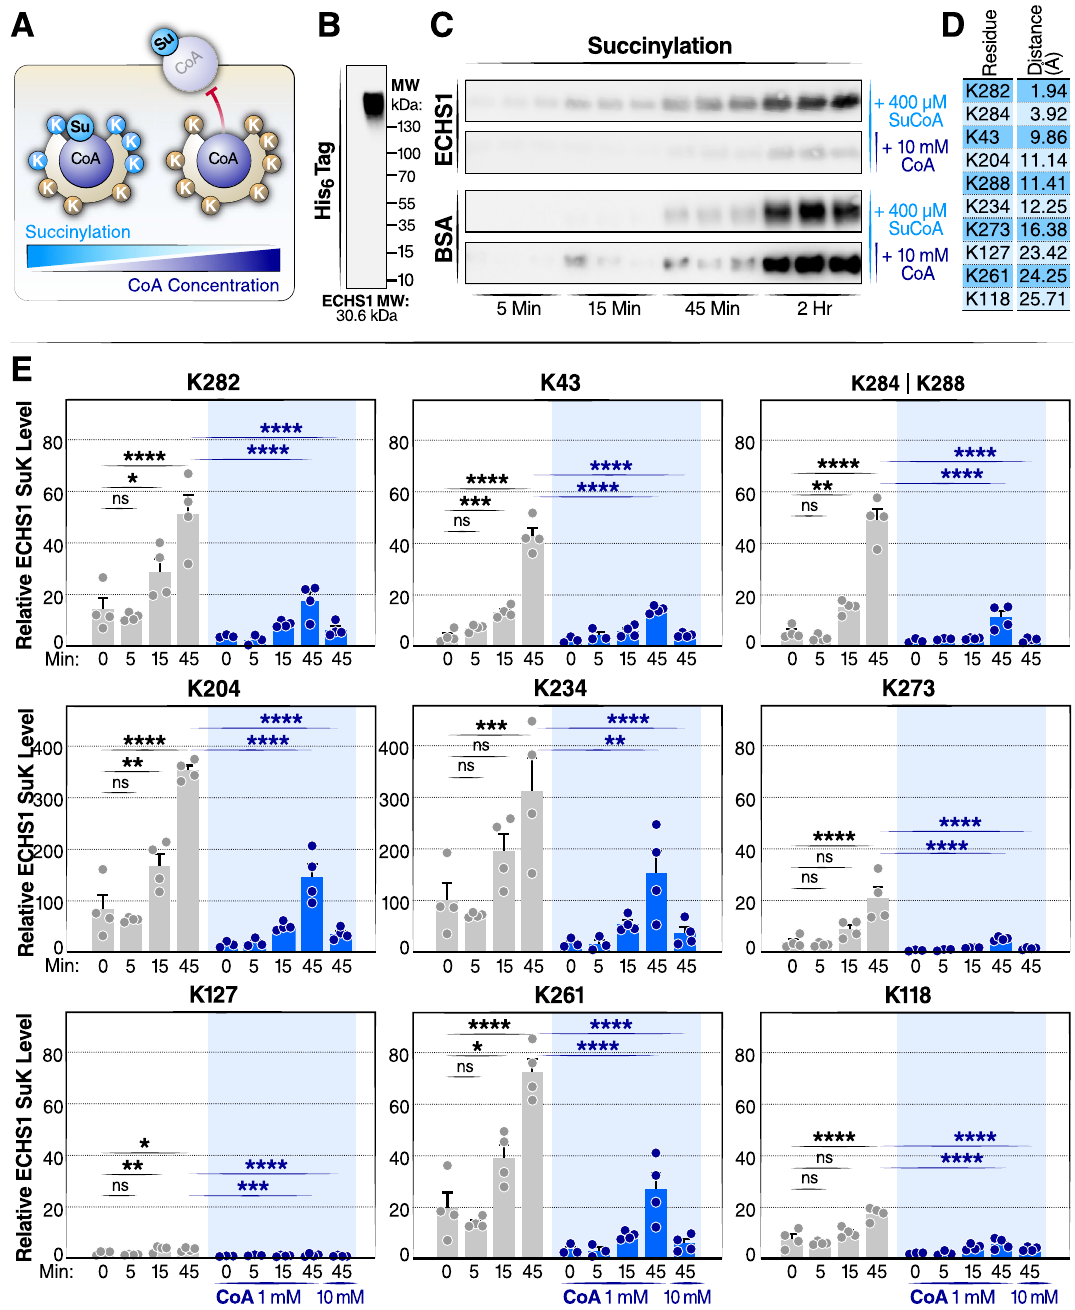
Figure 5. In-vitro succinylation of ECHS1 with succinyl-CoA is competitively inhibited by CoA ( a ) Schematic diagram of the succinylation of ECHS1 by succinyl-CoA (Su-CoA) and inhibition by CoA. ( b ) Western blot of human recombinant ECHS1 using native gel electrophoresis. ( c ) Western blot detection of succinyl lysine (SuK) levels in ECHS1 and BSA co-incubated with Su-CoA in the presence and absence of CoA for varying times (5, 15, and 45 min, and 2 h). ( d ) Distance of individual lysine residues to CoA on ECHS1. ( e ) Mass spectrometry time-course experiment measuring the change in succinylation levels at individual lysines on ECHS1. ECHS1 was co-incubated with 400 µM Su-CoA for 0, 5, 15 or 45 min and with 0, 1 or 10 mM CoA. The abundance of SuK levels for each residue was normalized to the ECHS1 negative control (not treated with CoA or Su-CoA), (N = 4 per treatment). * P < 0.05, ** P < 0.01, *** P < 0.001 and **** P < 0.0001; ns, not significant. A one-way ANOVA was performed. In the conditions not treated with CoA, each time point was compared to the 0 min group. In the 45-min conditions, both CoA-treated groups (1 and 10 mM) were compared to the group not treated with